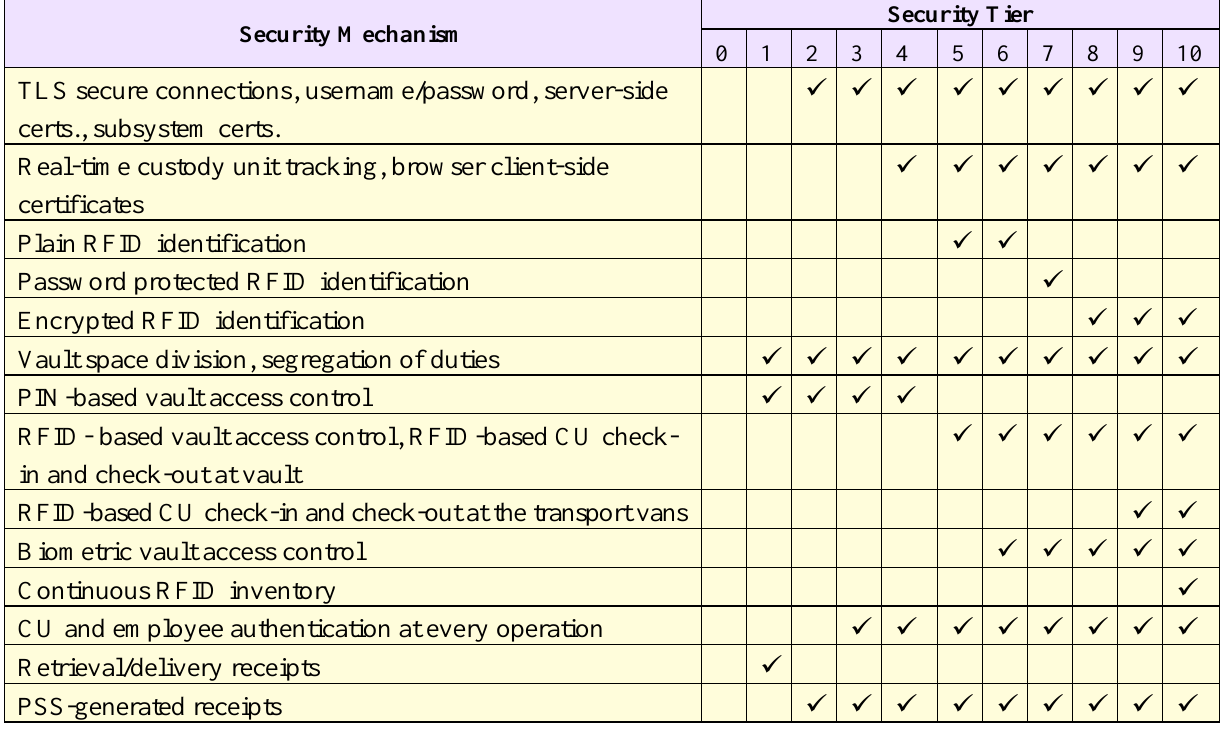
Table 1. Security mechanisms implemented in the different security tiers. Security Mechanism